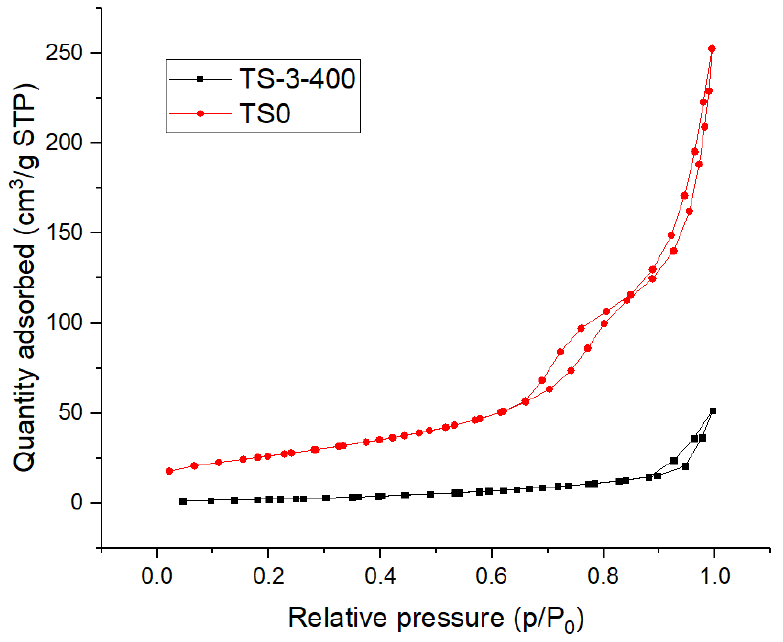
Figure 6. Adsorption-desorption curve of TS0 and